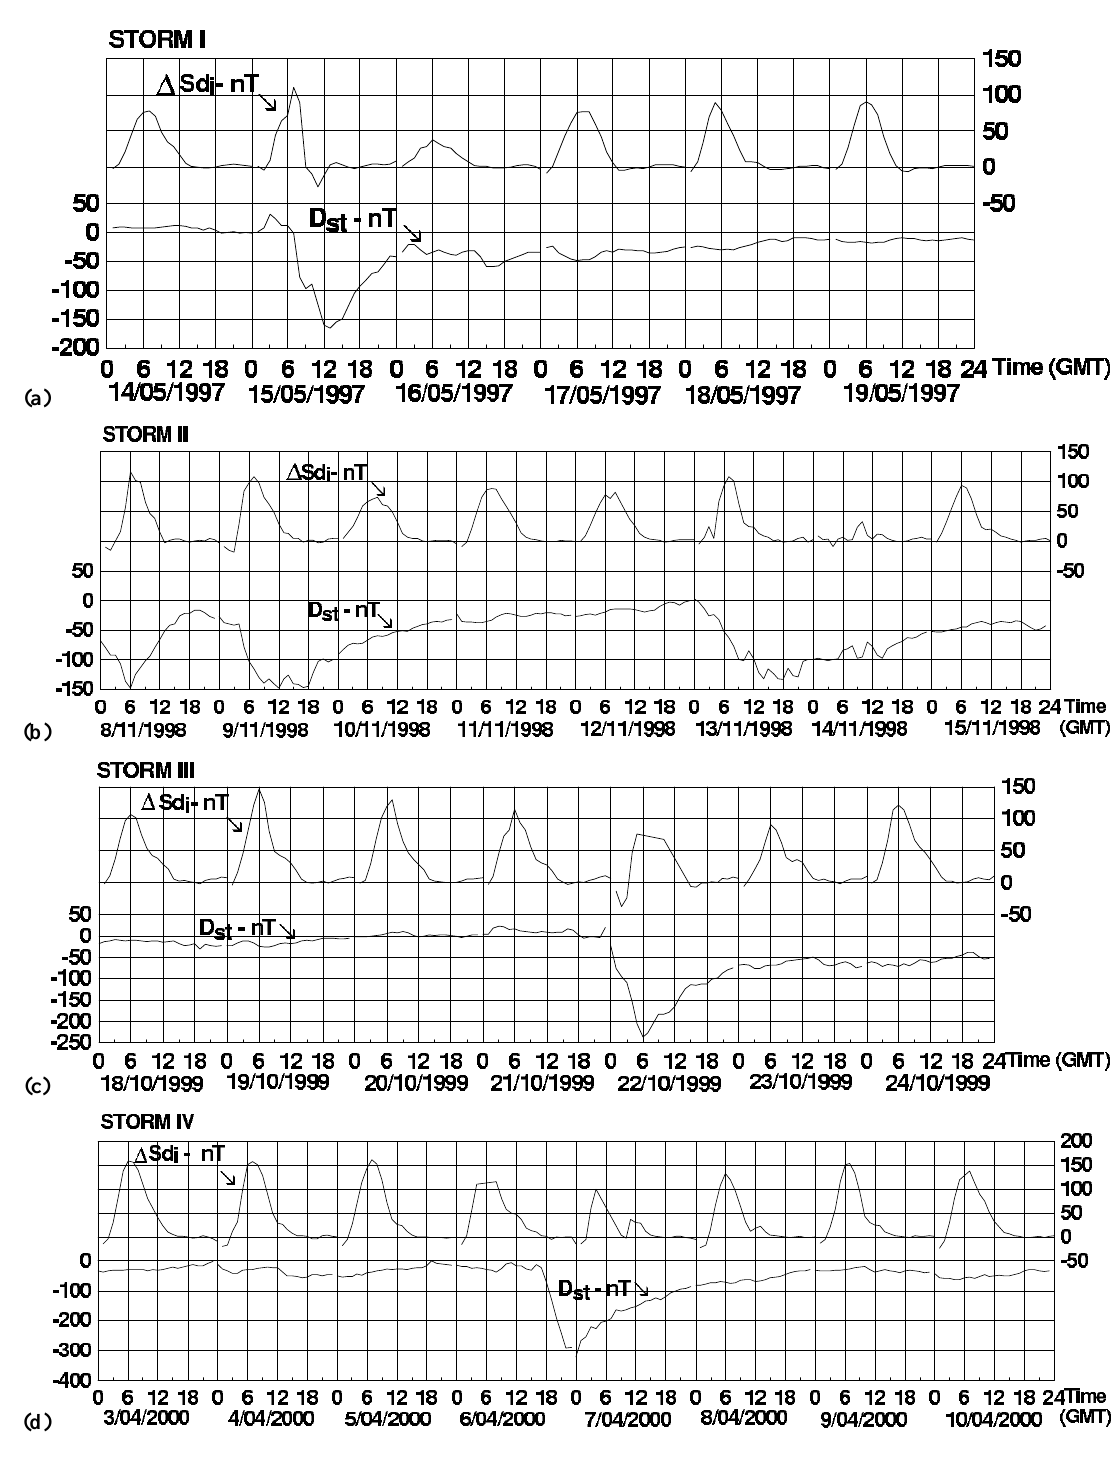
Fig. 1. Time variation of the storm time disturbance index (Dst) and equatorial electrojet strength (DSdI) during the period of storms I, II, III & IV,